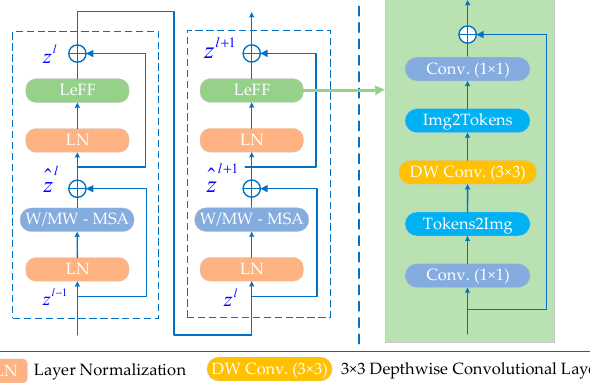
Figure 5. Structure of LeWin Transformer blocks in series and the LeFF module. Figure 6 illustrates how the feature map is divided into non-overlapping windows.